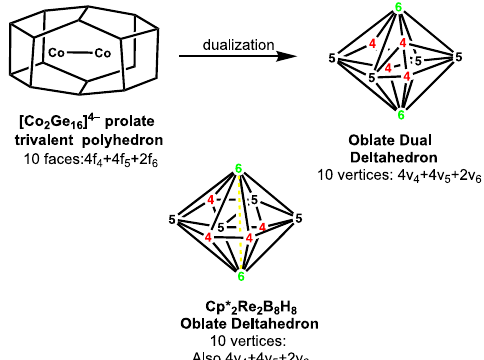
Figure 8. Dual relationship between the 16 ‐ vertex prolate ellipsoidal trivalent polyhedron in [Co 2 Ge 16 ] 4– and the 10 ‐ vertex oblate ellipsoidal deltahedron in Cp* 2 Re 2 B 8 H 8 .